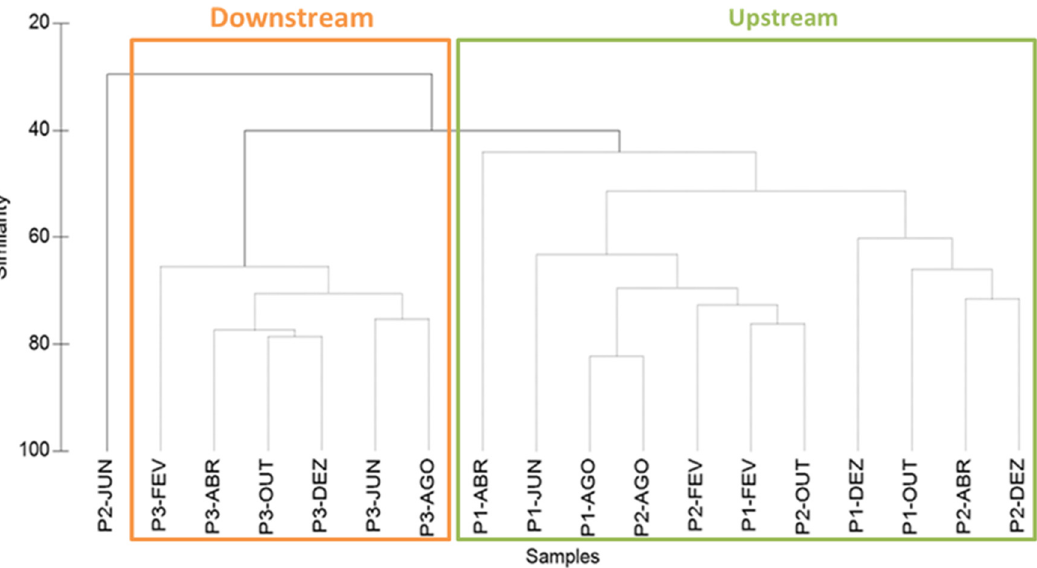
Figure 6. Copepod similarity analysis in Piranji Estuary (equatorial Southwestern Atlantic, Brazil, year 2015).